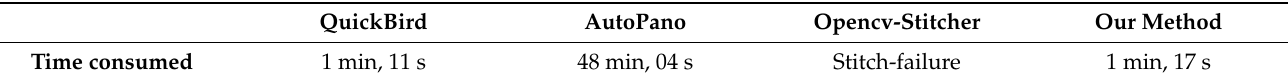
Table 9. Comparison of time consuming.